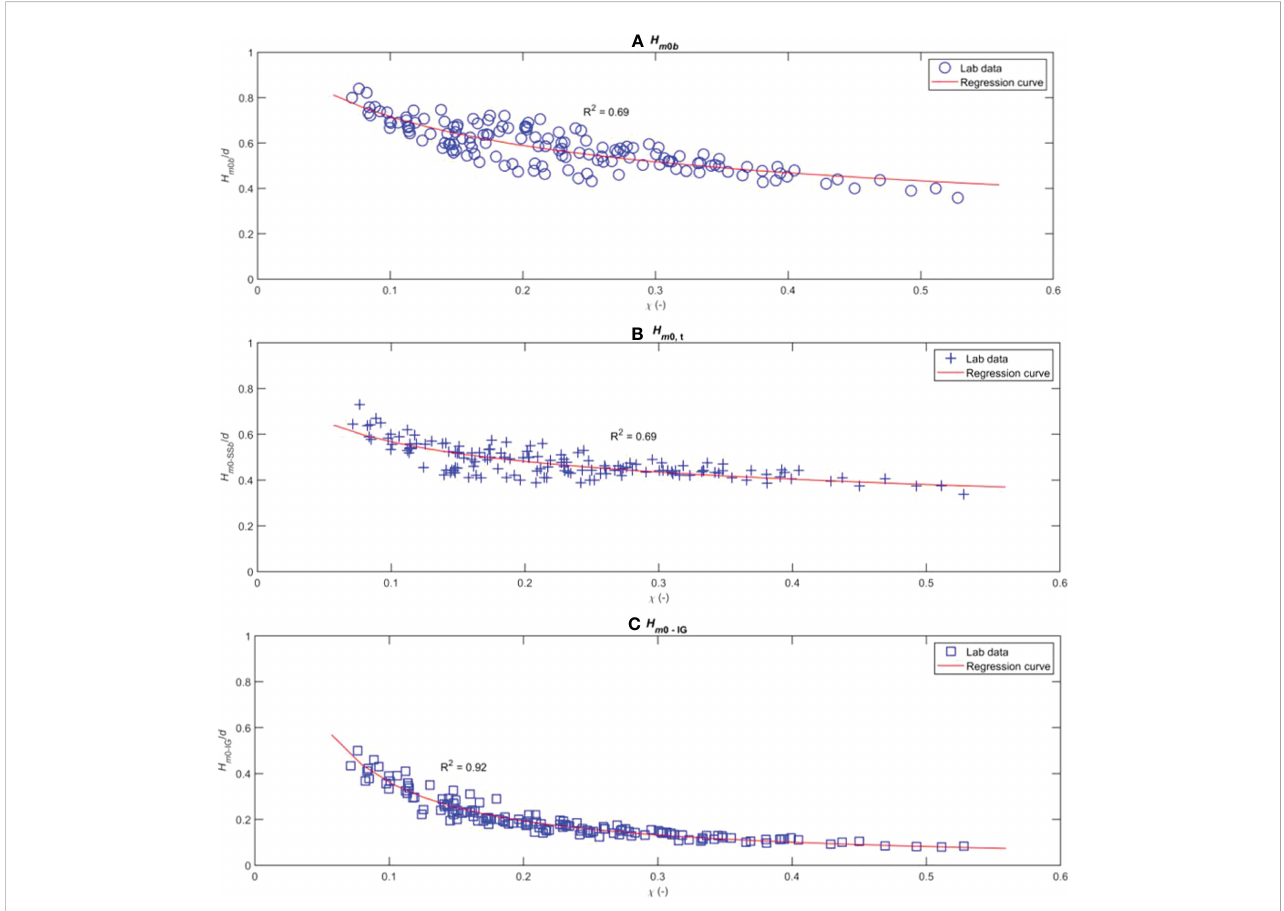
FIGURE 14 Dimensionless wave heights versus relative reef submergence. (A) Maximum total wave height, H m0b ; (B) total wave height, H m0t ; (C) IG-wave height, H m0-IG